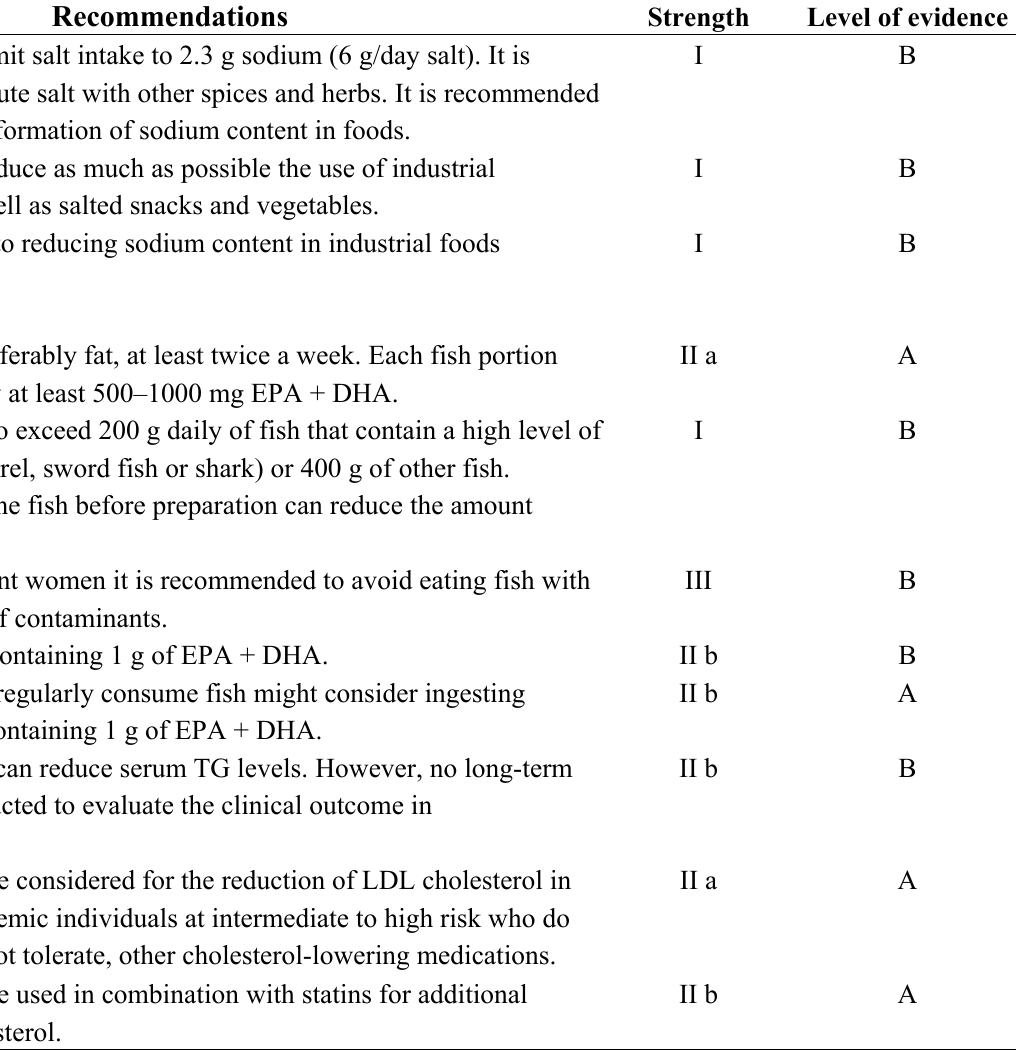
Table 8. Level of evidence and classes of recommendations for nutritional